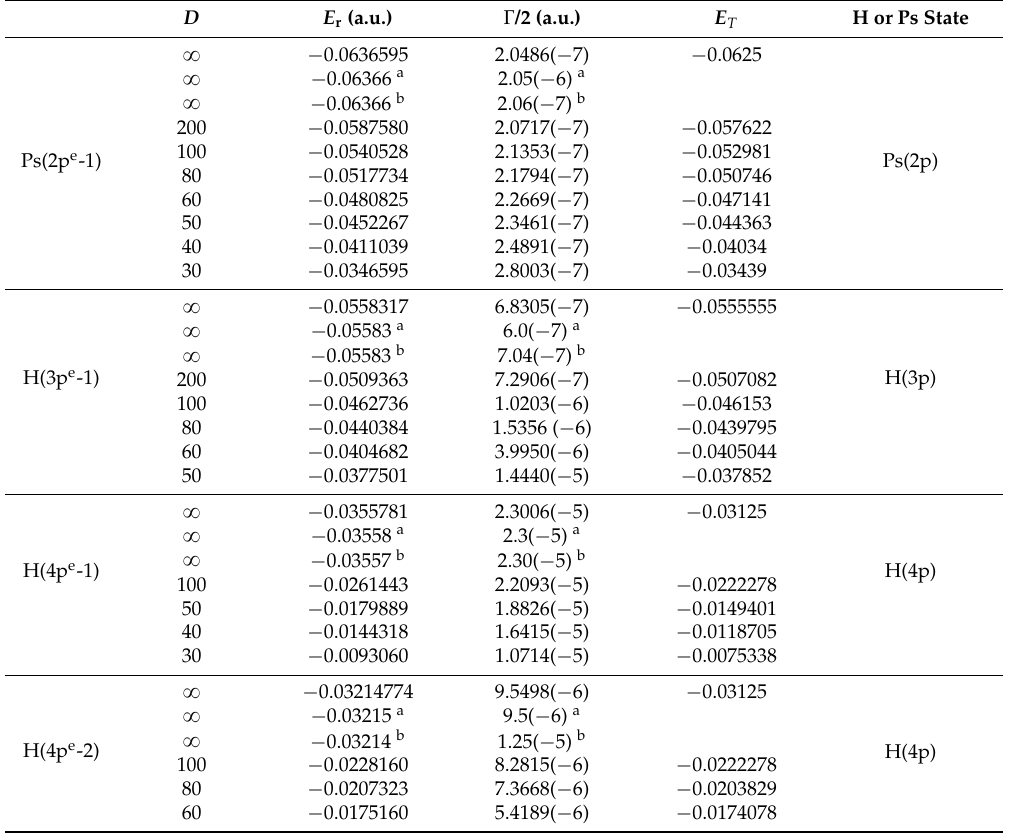
Figure 6. P -wave unnatural parity states: ( a ) resonance energy and ( b ) half-width for the H(3p e -1) state as a function of μ = 1/ D . Table 2. P -wave resonances with unnatural parity in the positron-hydrogen system with various Debye lengths D . The threshold energies E T are associated with the excited np states of the parent (H or Ps) atom. The notation A(−B) denotes. A × 10 −B . Units are in a.u.